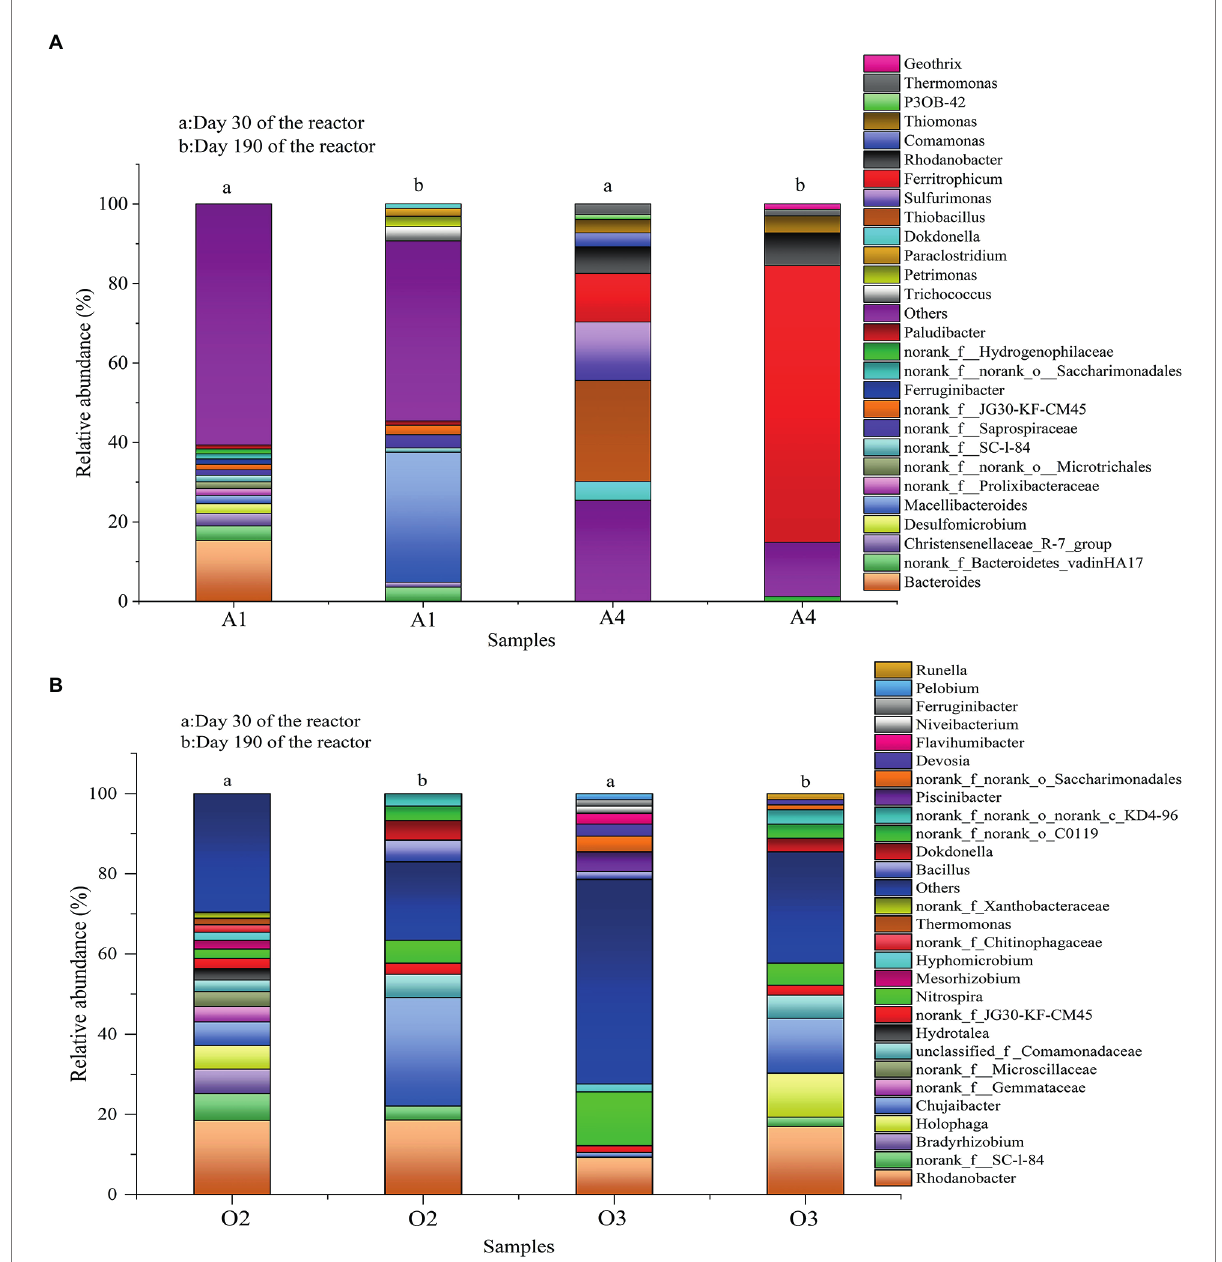
FIGURE 5 Changes in microbial community in the reactor (A) genus level of chambers A1 and A4; (B) genus level of chambers O2 and